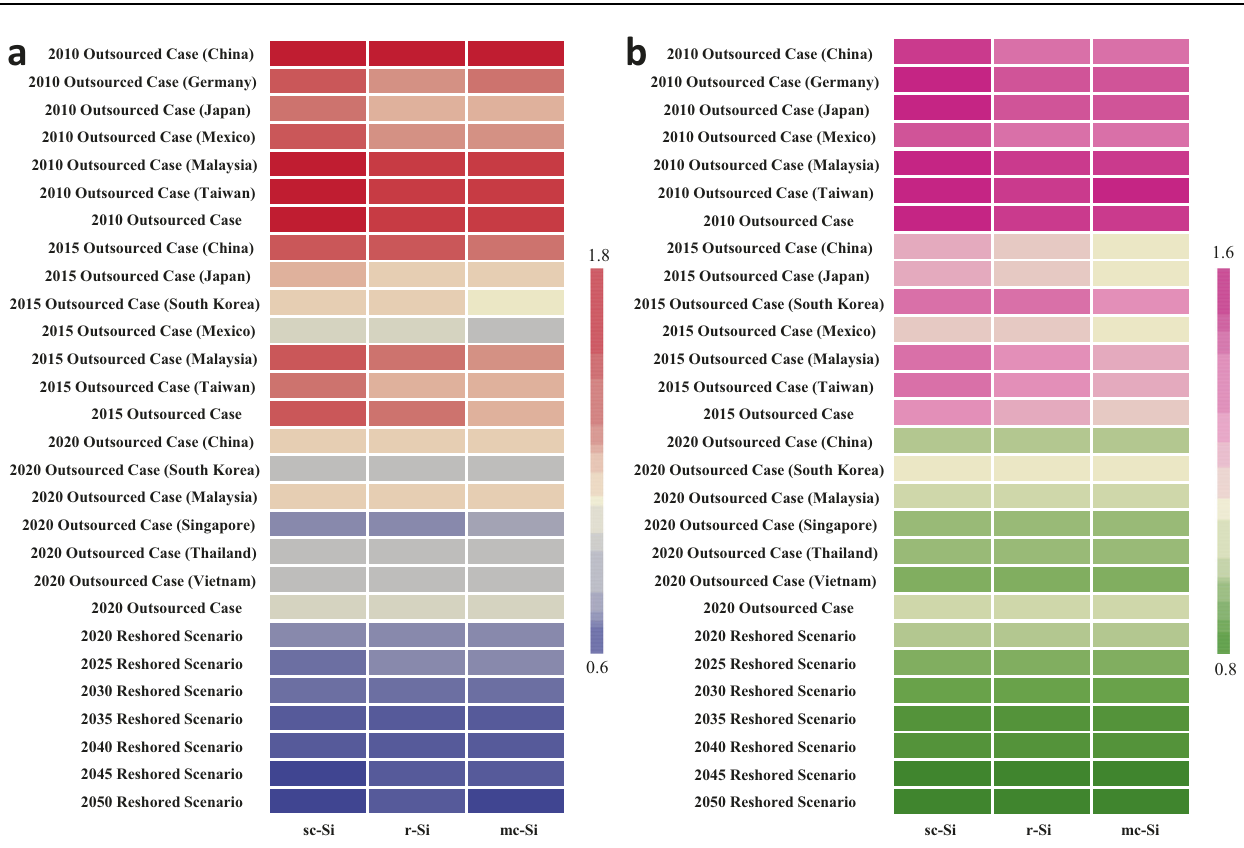
on the colors shown on the color bar. In particular, the red and pink colors representhighcarbonemissionfactorsandhighEPBT,suggestingmoreenergyand environmental burdens, while the blue and green colors represent low carbon emission factors and low EPBT, indicating lower burdens. The 2020 outsourced case is de fi ned as the reference for